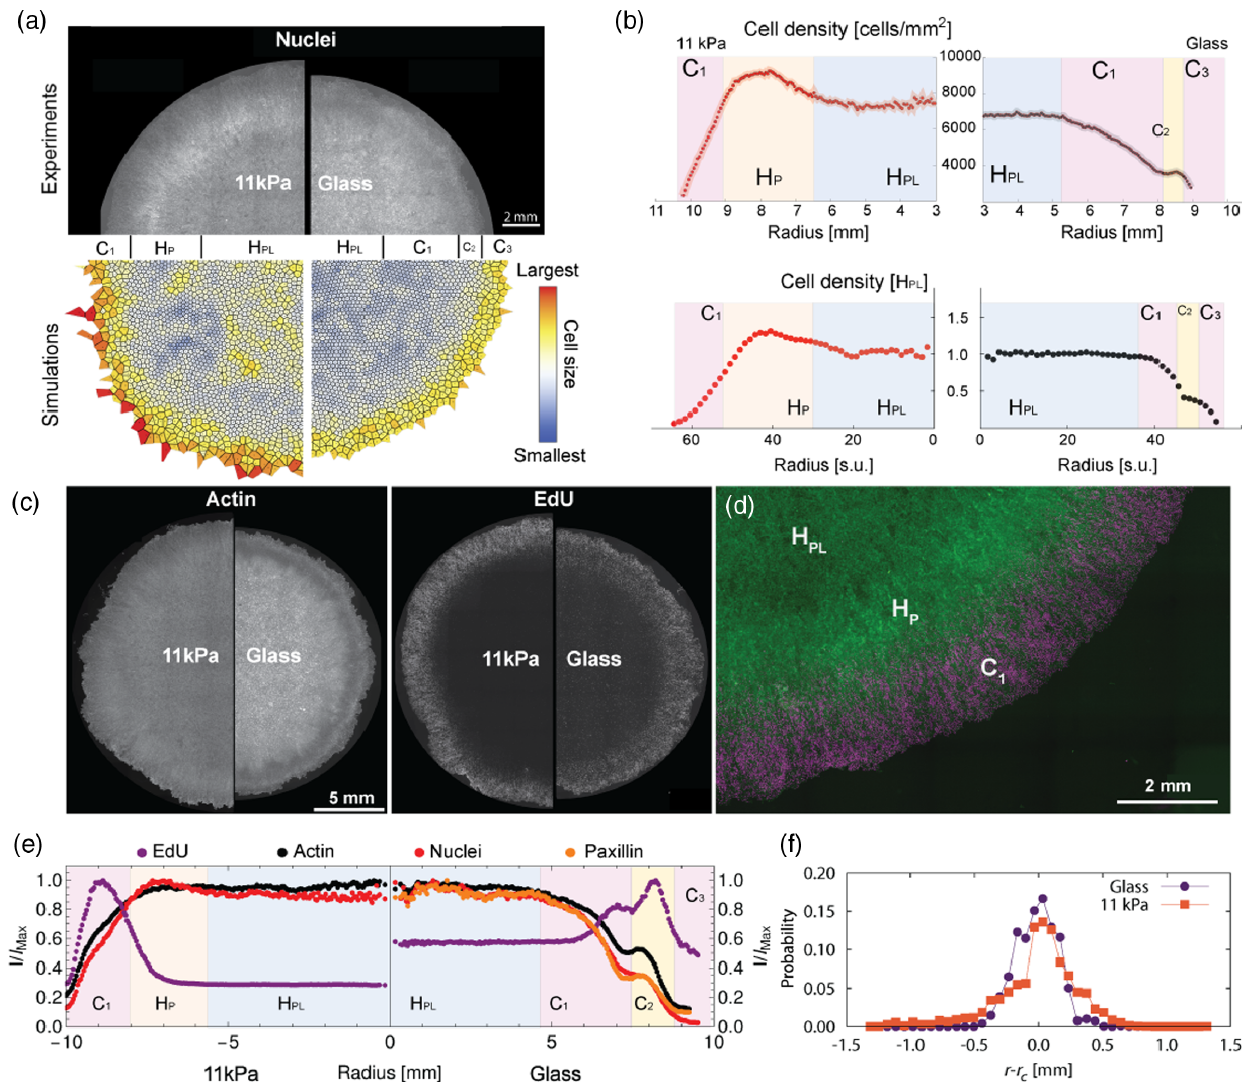
FIG. 3. Macroscopic organization of the tissue surrounding the homeostatic state on hard gels and glass. H and H stand for the PL P homeostatic state with inhibition of proliferation and locomotion and for the homeostatic state with inhibition of proliferation, respectively. Additional compartments are denoted with C , as defined in the main text. (a) Hoechst stained cell nuclei throughout the n tissues grown for 6 days (top panel) are compared to simulations (bottom panel). Colonies on hard gels (left panel) are compared to ones developed on glass substrates (right panel). The scale bar indicates 2 mm. Various compartments are indicated in between the simulation and experimental diagrams. (b) Experimental density profiles obtained from the linear relation between density and light intensity (top row) on gels (red curve on the left) and glass (black curves on the right); more details are given in Appendix D 1. Simulation counterparts are shown in the bottom row. Parameters are given in Table III, with f 0 ¼ 64 and Γ ¼ 0 . 5 and 2.0 for glass and hard gels, respectively. All values are identical for all cells; the macroscopic compartment they are in does not influence the parameters. (c) Experimental cell clusters on hard gels and glass substrates stained for actin and EdU, showing only residual proliferation in the H state. (d) Segment of a PL tissue grown on hard gels showing no proliferation within the H and H compartments. The purple, EdU stained nuclei are overlayed PL P with the Hoechst stain in green. (e) Intensity profiles for actin (black), nuclei (red), paxillin (orange, only on glass), and EdU (purple) through the colonies grown on hard 11 kPa gels and glass. (f) Tissue roughness evaluated by the normalized distributions of the deviations of the edge from the average